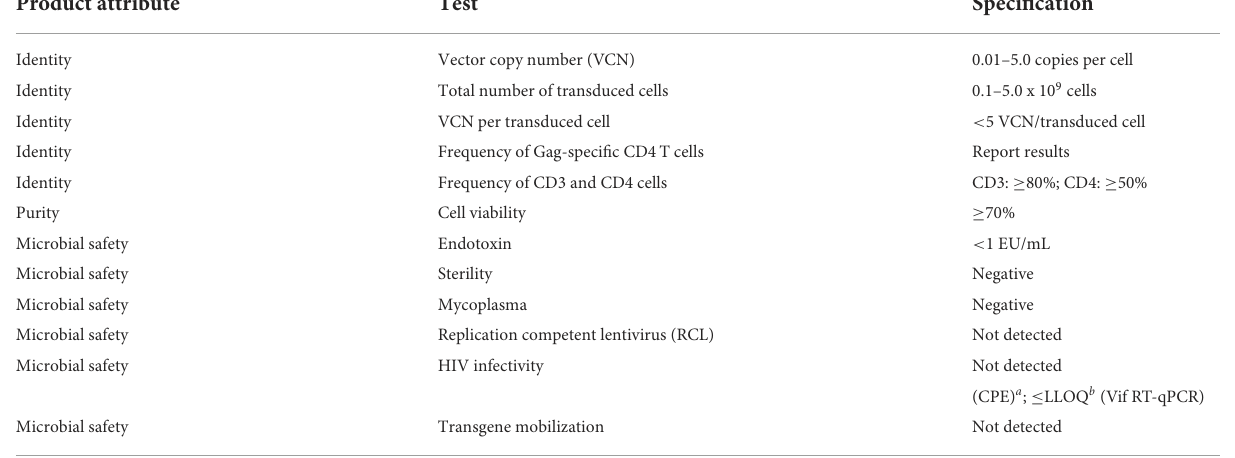
TABLE 2 Drug product release testing and